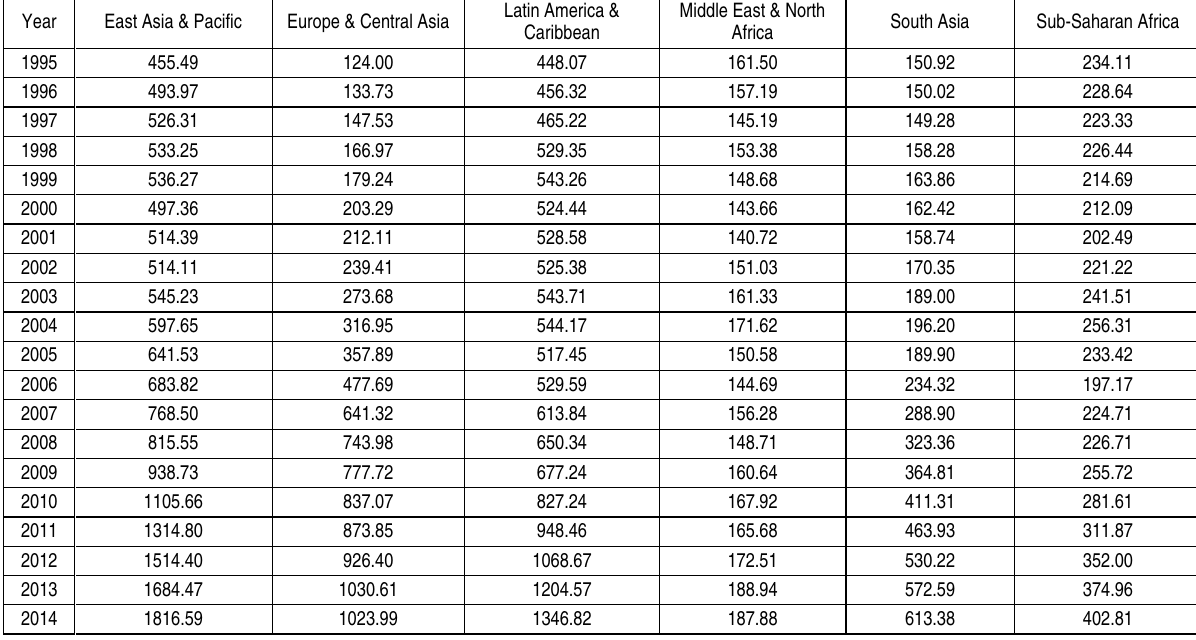
Table 1. Trends in total gross external debt region-wise 1